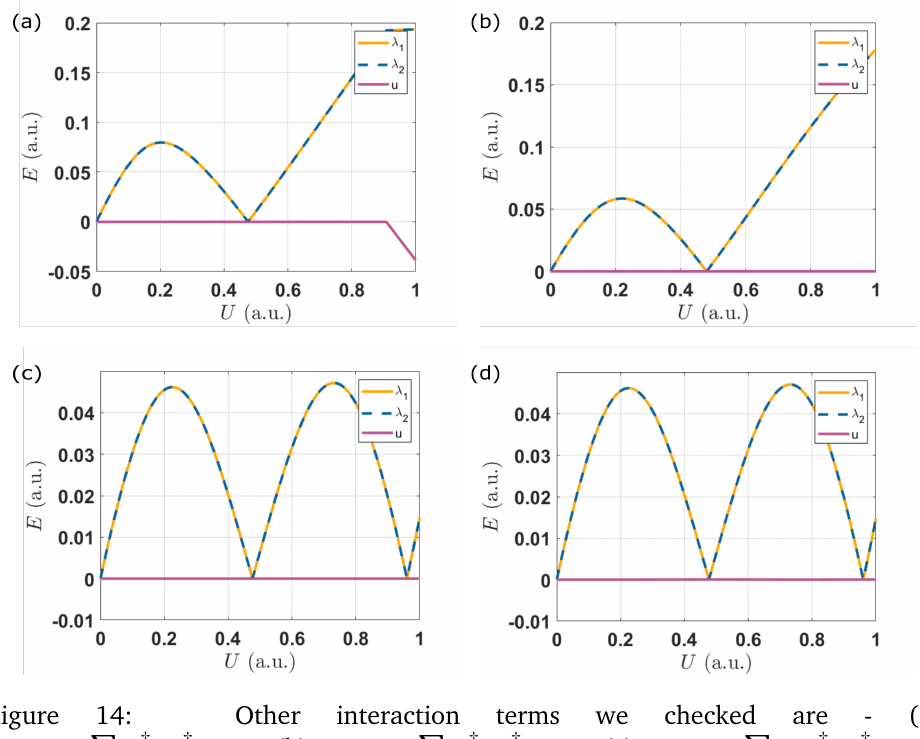
c † c c † c , (c) H i i + 2 i i i + 2